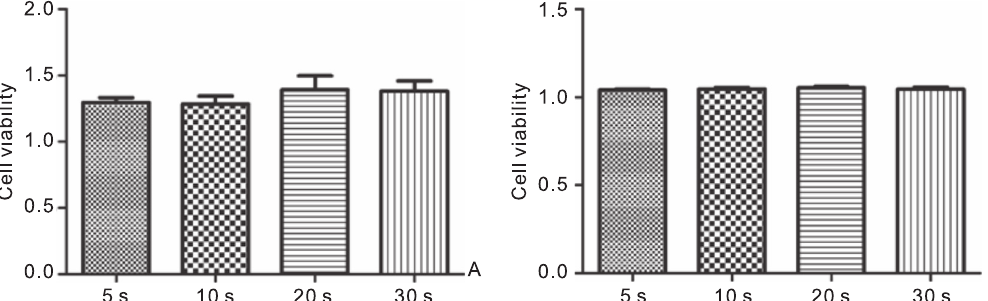
Figure 3 Effect of different exposure time on HCAEC viability was potted by column graph. The error bars represented the standard deviation ( n =3). Forty-eight hours after transfection, HCAECs were treated with CCK-8, and then were incubated for 4h and 48h, respectively. (A) The cells were incubated for 4h, and (B) were for 48h in suspended cell group. The change of cell viability was no